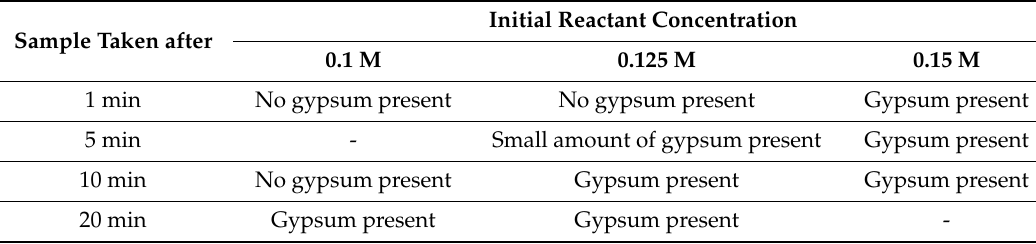
Table2. SummaryofgypsumcontentinthewashedprecipitatedsolidstakenatgiventimesintheMgSO 4 + Ca(OH) + CaSO → Mg(OH) · 2H 2 2 4 2 O reaction carried out with di and keeping the reactant–additive ratio constant (molar ratio of Ca:Mg:Citric acid = 0.1:0.1:0.0015).